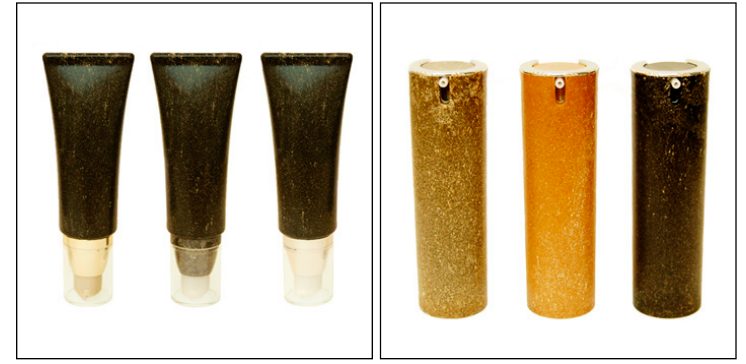
Figure 11. Cosmetic packaging products made from wood plastic composites [112].